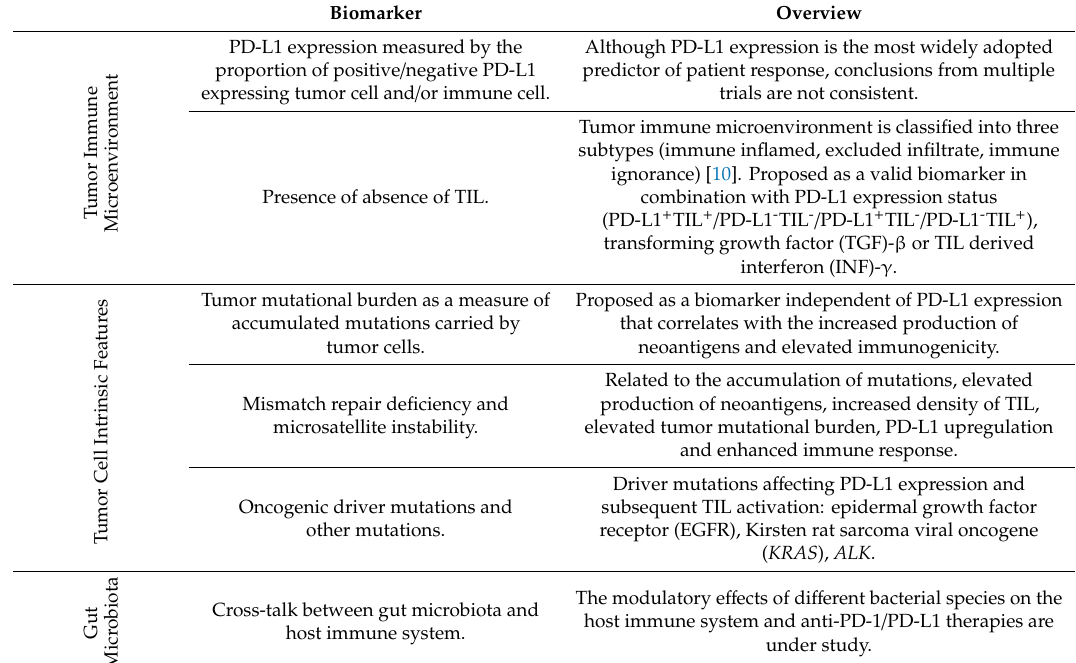
Table 1. Biomarker models for predicting e ffi cacy of PD-1 / PD-L1 inhibitors [10]. Biomarker